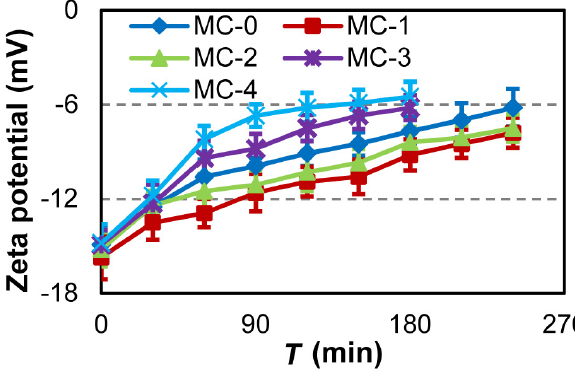
Figure 2: Zeta potential of the MC-MWCNT suspensions at different storage